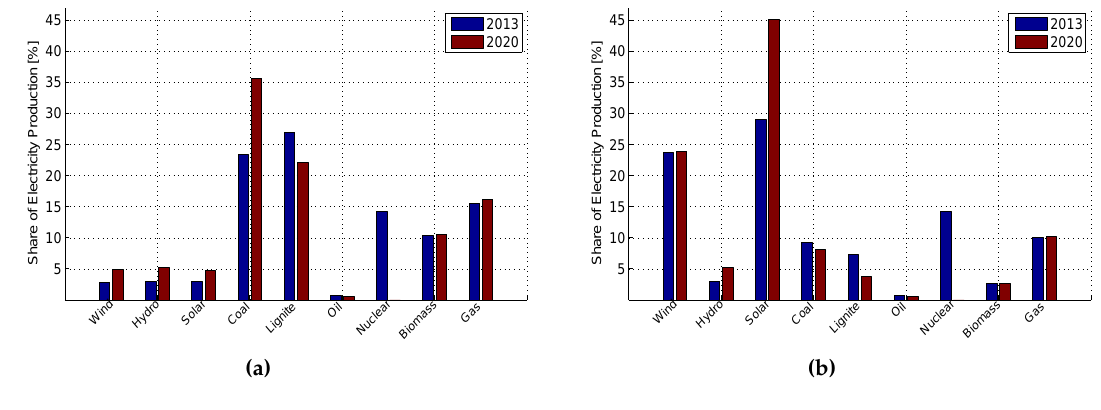
Figure 4. Power generated by different technologies at times of lowest and highest renewables penetrations in December 2013 and 2020. ( a ) 7% penetration of renewables; ( b ) 68% penetration of